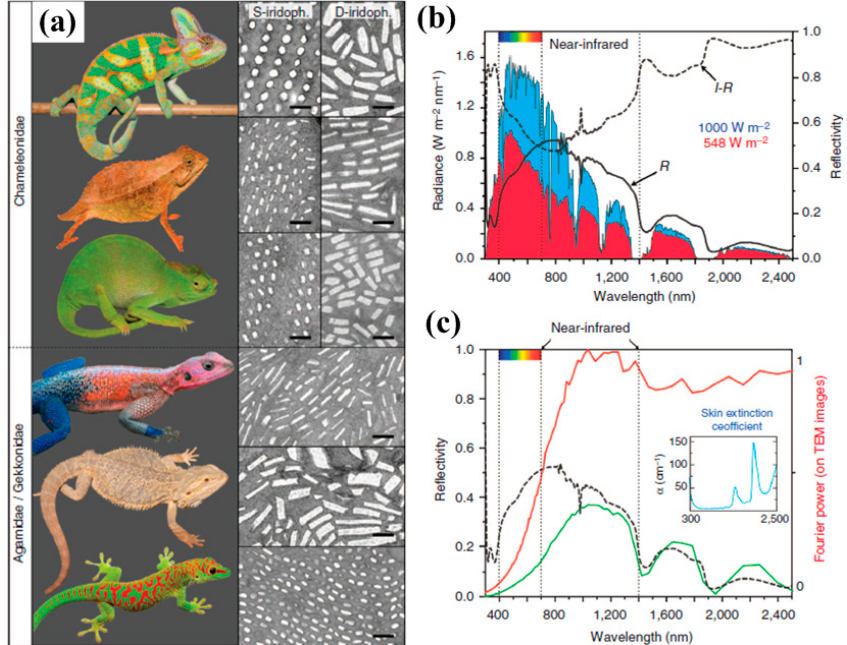
Figure 1. ( a ) Chamaeleonidae (top to bottom: Chamaeleo calyptratus, Rhampholeon spectrum and Kinyongia matschiei) exhibit two superposed layers of (S- and D-) iridophores, whereas agamids (the sister group to chameleons) and gekkonids have a single-type iridophore layer (top to bottom: Agama mwanzae, Pogona vitticeps, and Phelsuma grandis). Scale bars, 500 nm. ( b ) Reflectivity (R) of a panther chameleon white skin sample and solar radiation spectrum (blue curve) at sea level. ( c ) Fourier power spectrum and reflectivity of a panther chameleon red skin sample. Inset, skin extinction coefficient as a function of wavelength. All figures are adapted from reference [80].